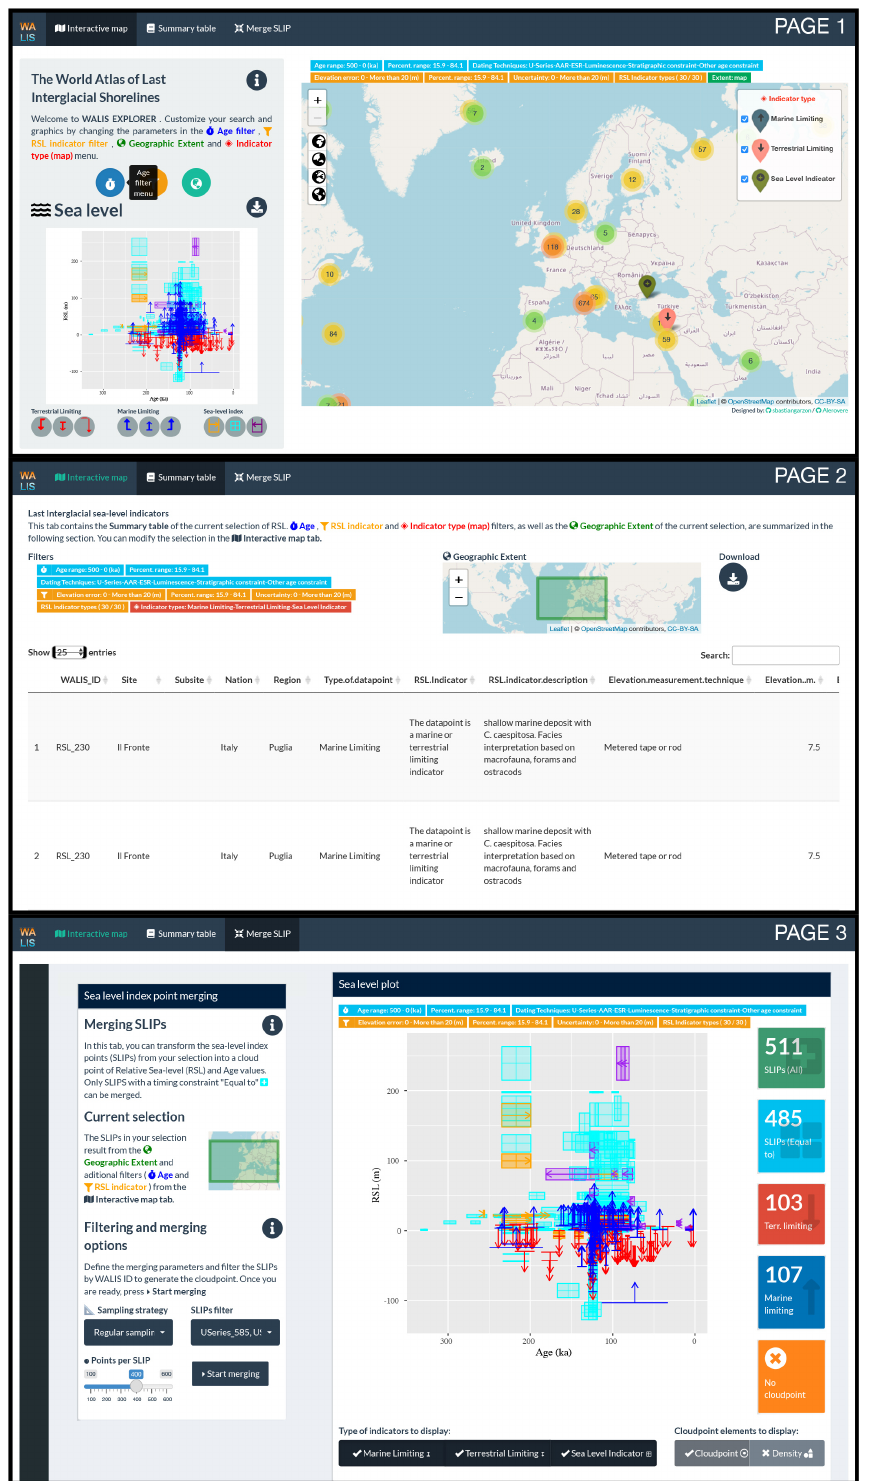
Figure 5. Screenshots of the three pages of the WALIS data visualization, version 2.0. The tool is available at https://warmcoasts.shinyapps. io/WALIS_Visualization/ (last access: 15 December